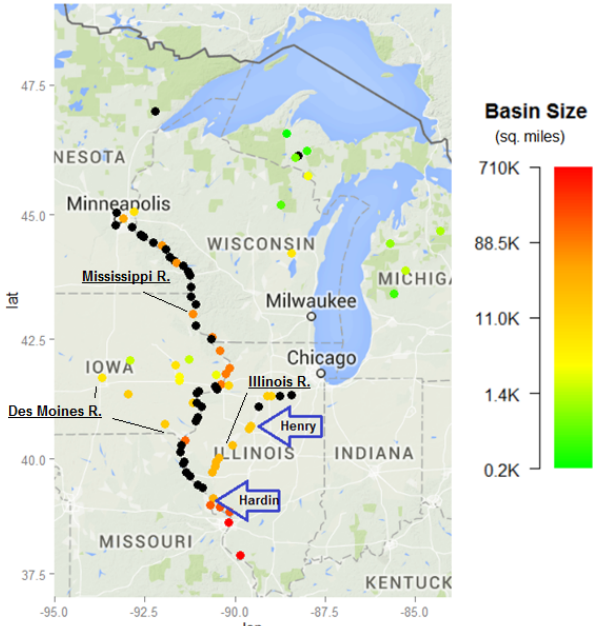
Figure 2. River gauges for which the North Central River Forecast Center publishes forecasts daily. Henry (HYNI2) and Hardin (HARI2) are indicated with arrows. For gauges indicated by black dots the basin size is missing. The color scale for basin size in square miles is